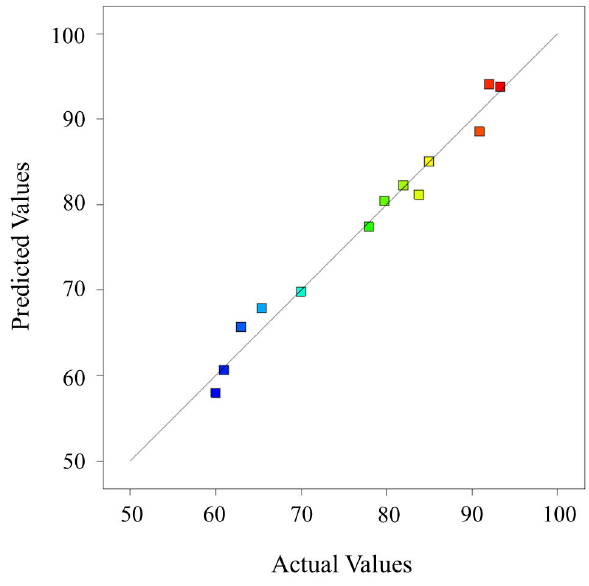
Figure 5. Predicted vs. observed values for adsorption efficiency.